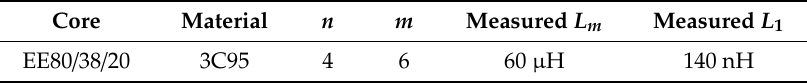
Table 4. Characteristics of the realized transformer.